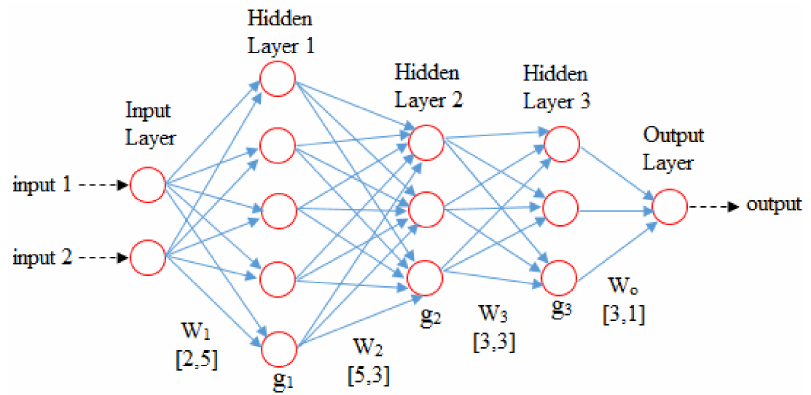
Figure 5. The MLP network